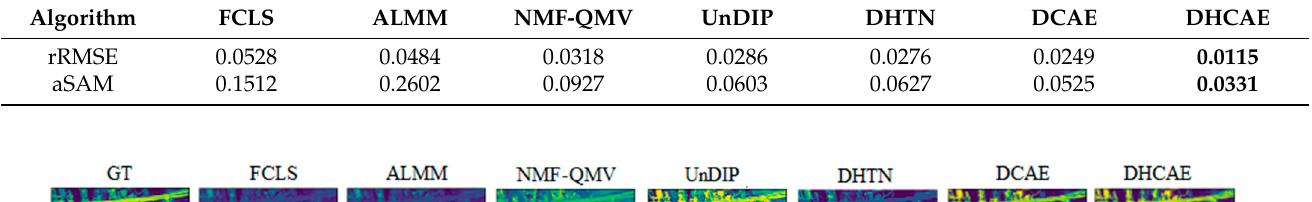
Table 4. Quantitative performance on the urban dataset without noisy bands by various approaches. The best result is shown in bold.